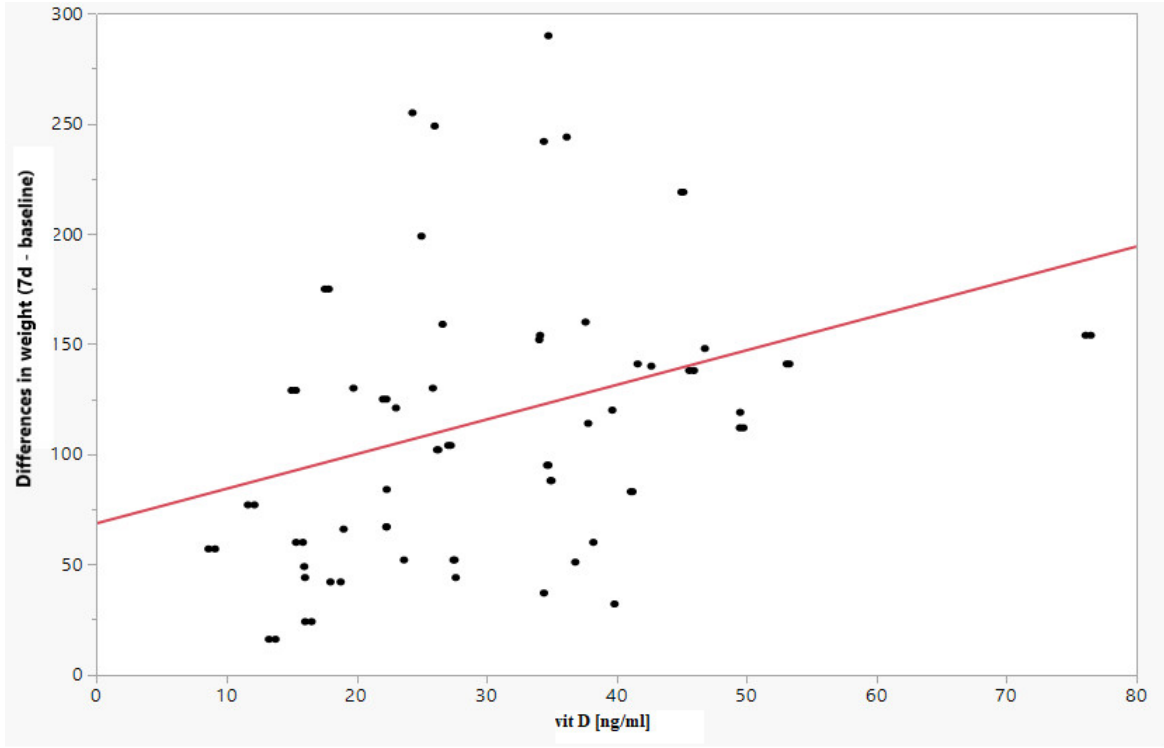
Figure 2. Increase in fetal weight on 7days of observations depending on the vitamin D level.